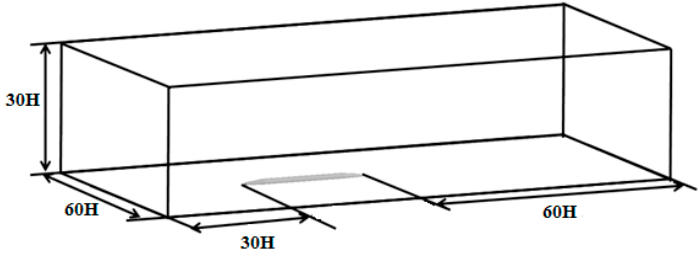
Figure 7. Computational domain.